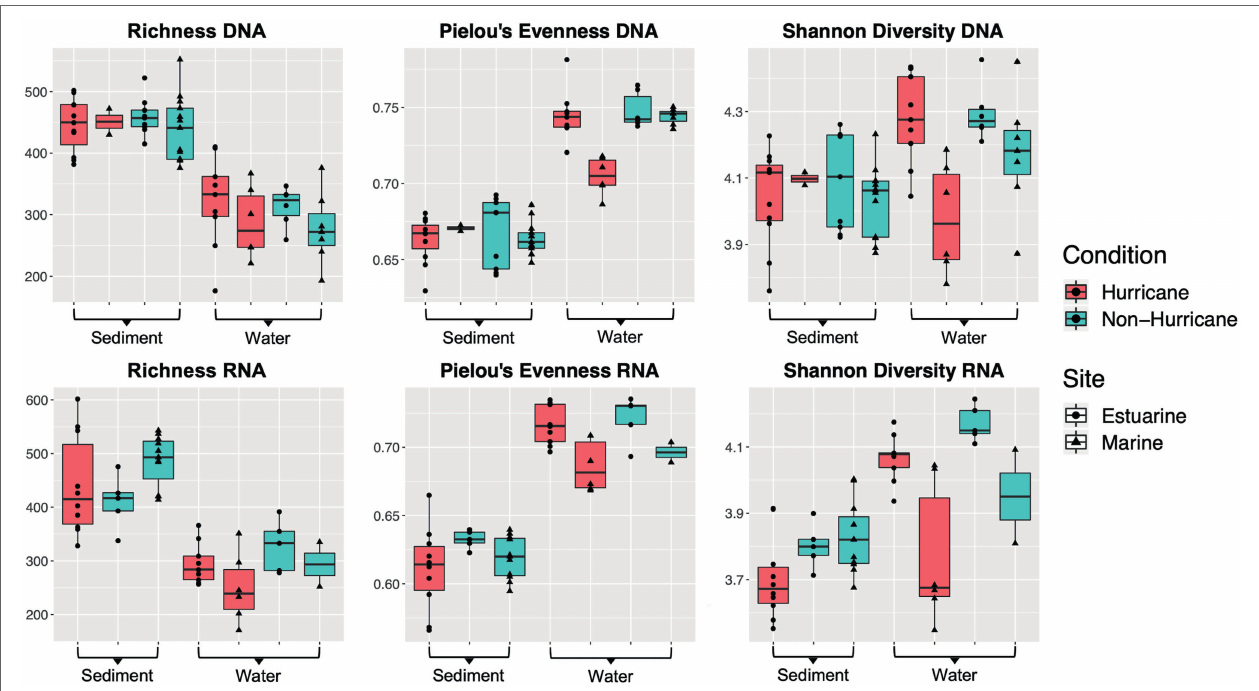
FIGURE 4 | Boxplots of microbial community diversity indices. Microbial communities at marine sites (>25 ppt) exhibited lower Shannon diversity (Mann–Whitney U test: W = 7, p < 0.01) and lower taxonomic evenness ( W = 0, p < 0.001) within surface waters after hurricane conditions compared to non-hurricane